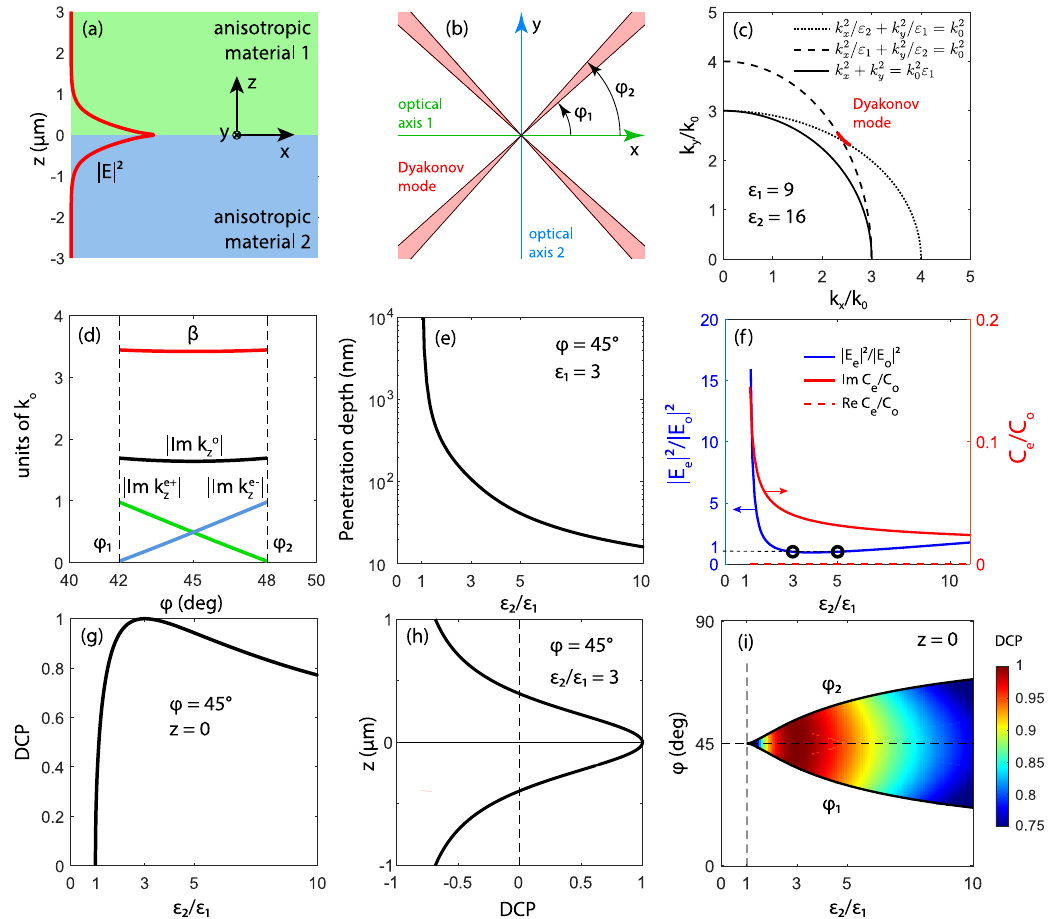
and φ are the limits of the φ -range of the existence of 1 2 ( ε / ε ) and φ ( ε / ε ) . Colormap shows the anisotropy factor and azimuthal 2 1 2 1 2 1 / ε where γ (cid:1) ε is the anisotropy factor. In Eq. (5), all k z are 2 1 purely imaginary and the signs of square roots are chosen in such a way that the solution decays with distance from the interface in upper and lower half-spaces. The numerical solution of the Equation (4) for the Dyakonov wave is represented in Figure 1c by the red curve. One can see that the DSW is located near the intersection of the dispersion curves of extraordinary waves with k z (cid:1) 0 in the upper and lower half-spaces. The ( k , k ) range of the existence of DSW determines the x y narrow domain of azimuthal angle φ near the bisector